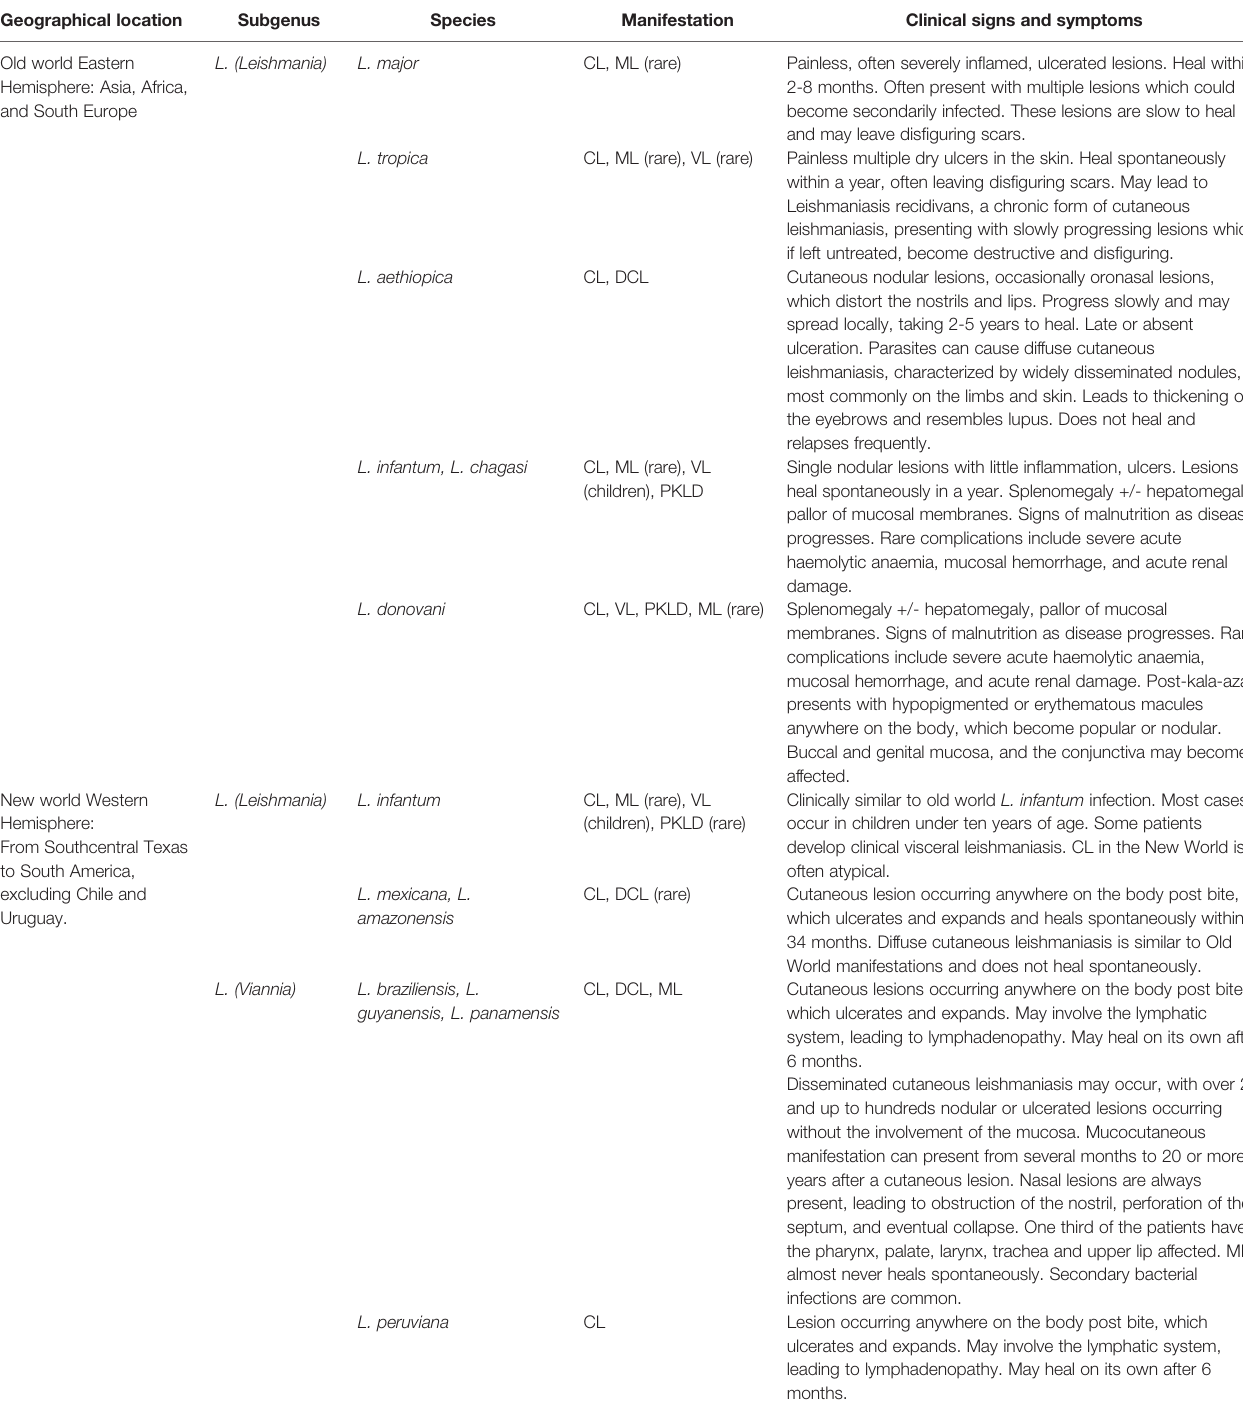
TABLE 1 | Human manifestation of leishmaniasis caused by Leishmania